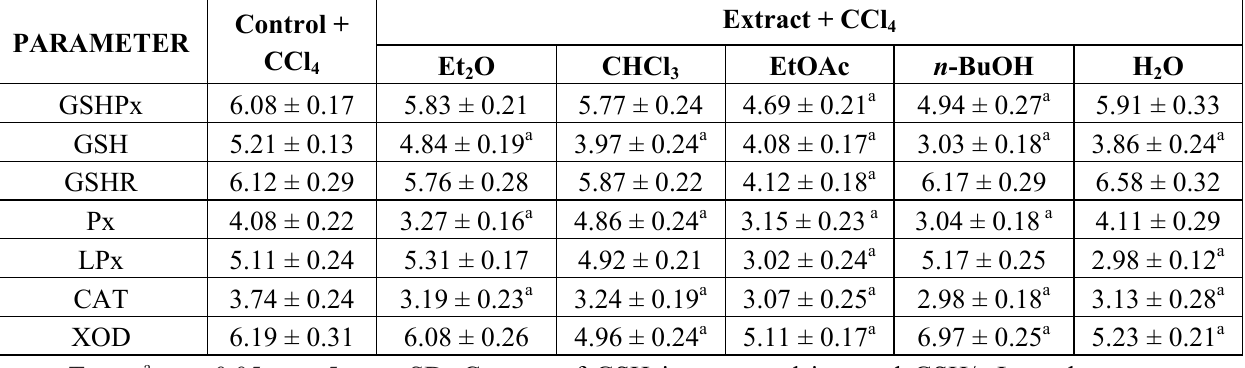
Table 6. Effect of extracts of M. melissophyllum leaves and CCl parameters in blood